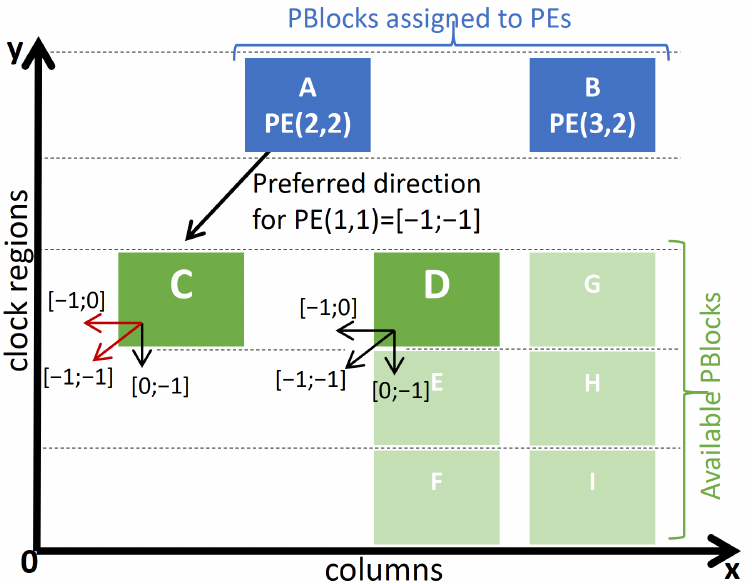
Figure 9. Directional consistency in PBlock selection process. In logical array PE(1,1) is located in direction [ − 1, − 1] from its predecessor PE(2,2). To preserve consistent geometry, it should be assigned to a region situated below and to the left of A. However, in the next iteration more elements—PE(0,0), PE(0,1), PE(1,0)—need to be located farther in that direction. Although the position of C in relation to A is consistent with PE(1,1) to PE(2,2) direction, selecting C would result in later placement of elements PE(0,0) and PE(0,1) to the right of PE(1,1)—as no regions are available in their preferred directions. Moreover, if D is used for PE(2,1) or worse PE(3,1), too many elements will opt for PBlocks E and F, resulting in some of them being placed far from their optimal location. Despite